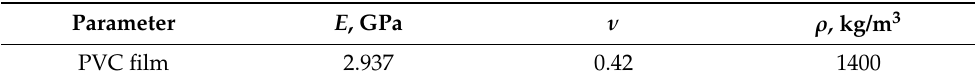
Table 1. Parameters of the PVC film (Vintec ® Clear PVC).